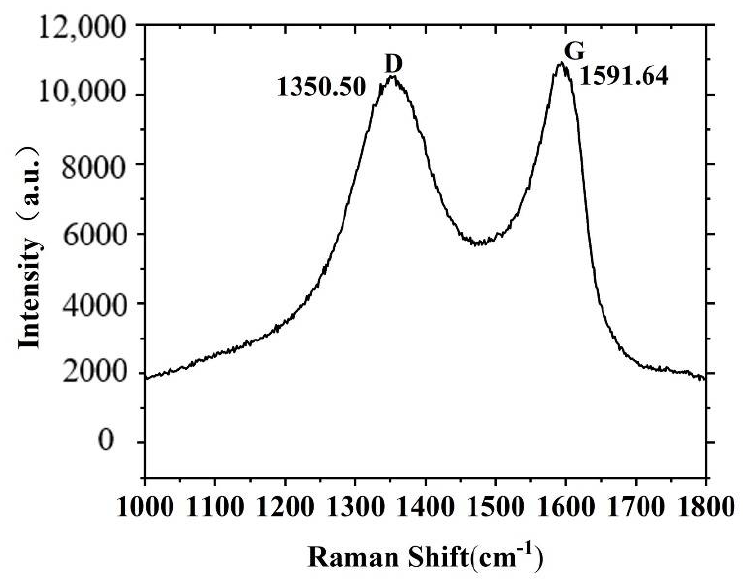
Figure 2. Raman spectrum of GO prepared in this study. Figure 3a–c is the SEM image of the graphene oxide foam in three different directions.